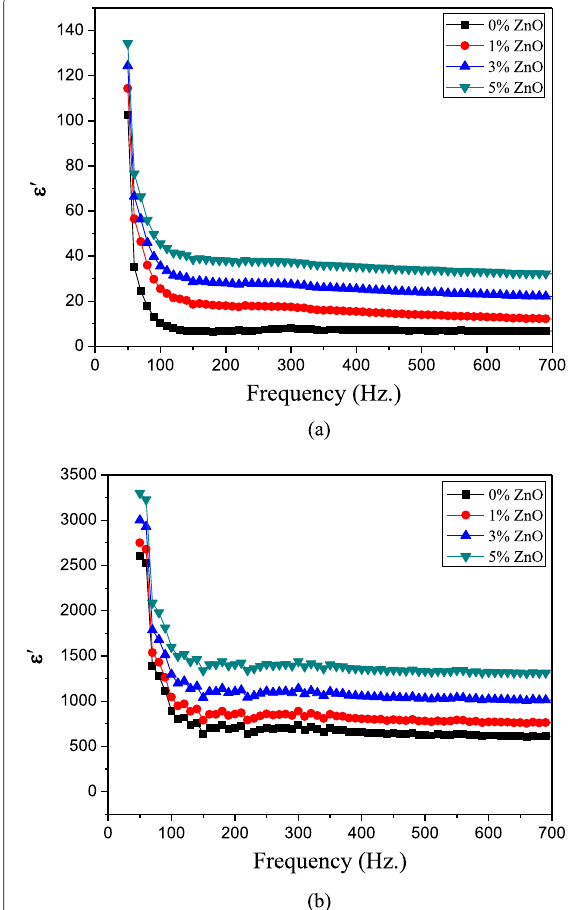
Fig. 6 Frequency dependence of dielectric constant ε ′ for zinc oxide nanoparticle‑filled (i.e., 0, 1, 3, and 5%) cross‑linked polyethylene irradiated at 0 and 25